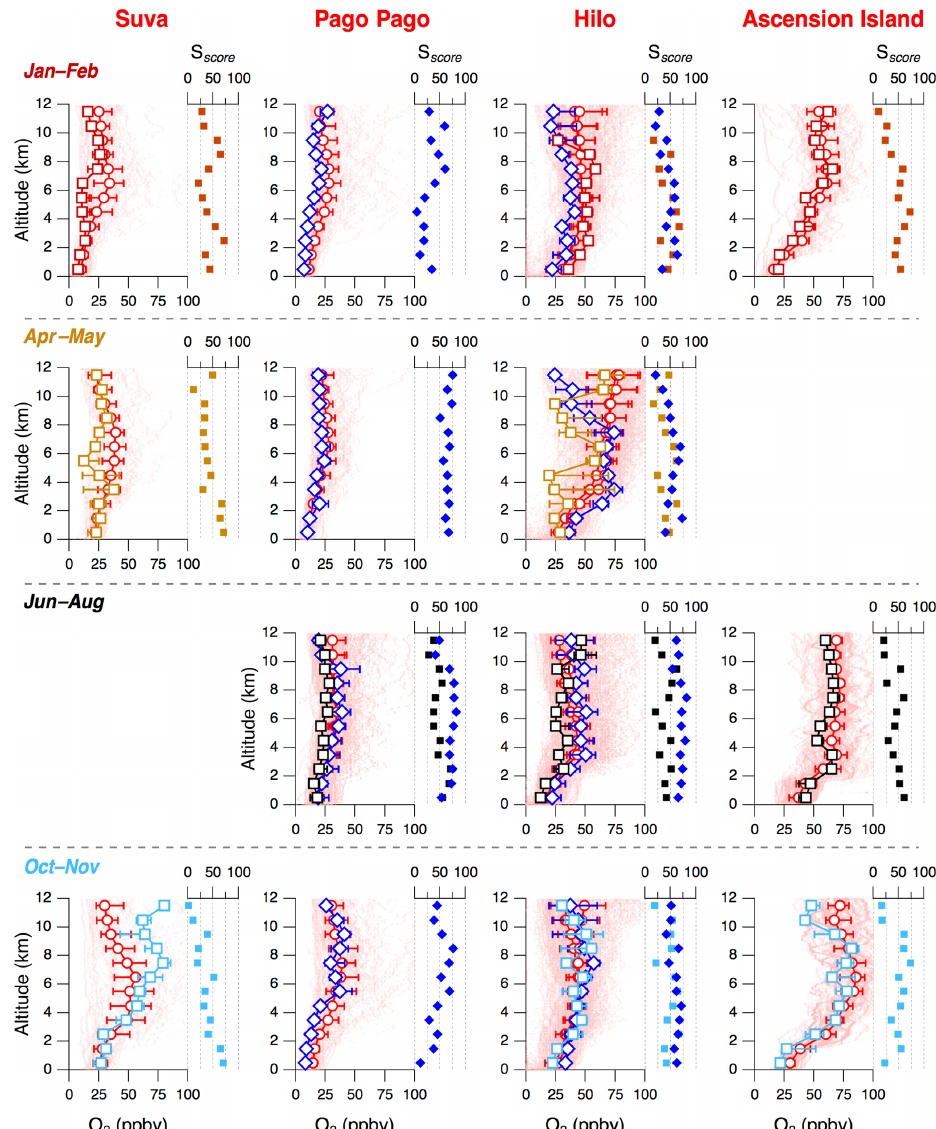
Figure 5. Seasonal comparison of 1km vertically binned ATom (colored squares) and HIPPO (blue diamonds) median O 3 with ozonesonde (red circles) records at four sites in the tropics (Suva in Fiji, Pago Pago in American Samoa, Hilo in Hawaii, and Ascension Island). Markers indicate the median, and the bars are the 25th and 75th percentiles. The S score is a metric of how well ATom and HIPPO 1km binned O 3 probability distribution functions (PDFs) overlap with the corresponding 1km binned O 3 PDFs from ozonesondes. The S score shown using squares compares ATom with ozonesondes, and the S score shown using blue diamonds compares HIPPO with ozonesondes. The pink dots show every O 3 data point measured by ozonesondes for the timeframes indicated in Table